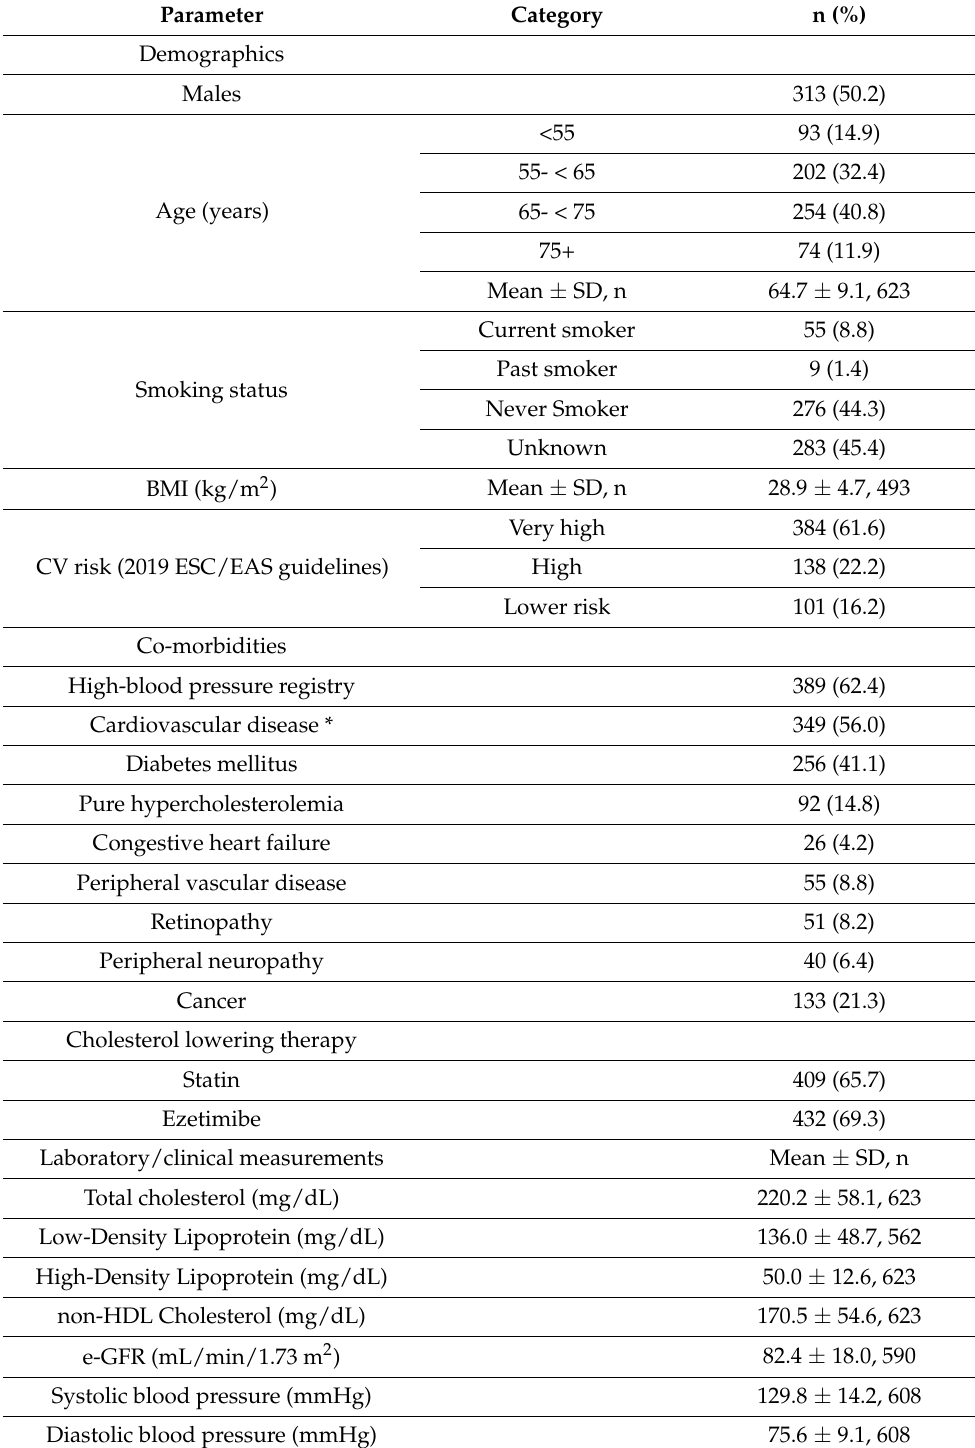
Table 2. Baseline characteristics of included patients (N =